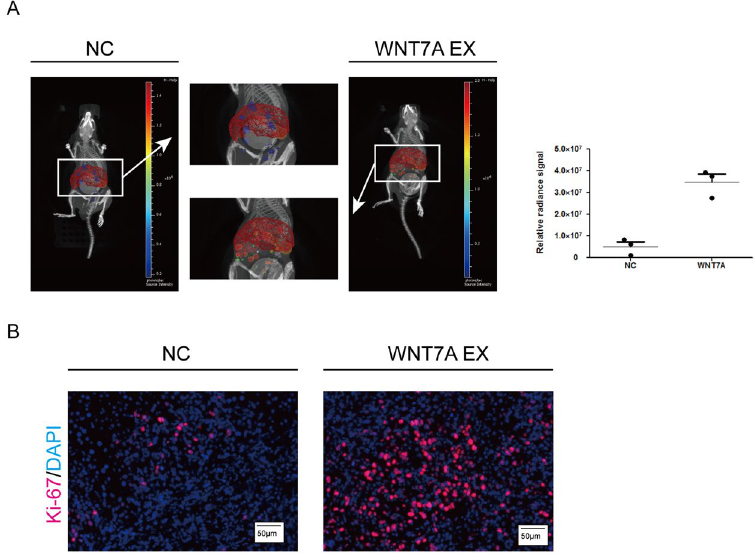
Figure 5. Over-expression of WNT7A promotes the migration capacity of pancreatic cancer cells in vivo . ( A ) Orthotopic xenograft were performed in mice by injected with stably transfected cell lines and bioluminescence of metastatic sites are shown. ( B ) Immunofluorescence of orthotopic xenograft liver were performed in which red staining represent Ki-67.